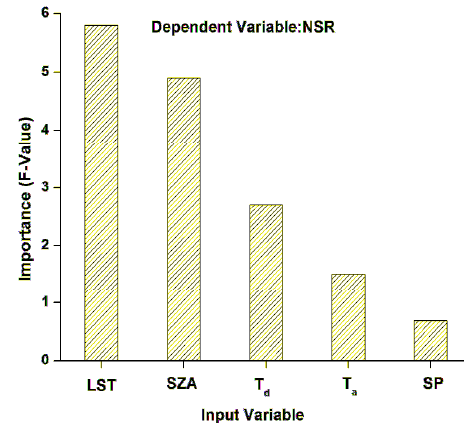
Figure 3: Input variables selection through statistical feature selection